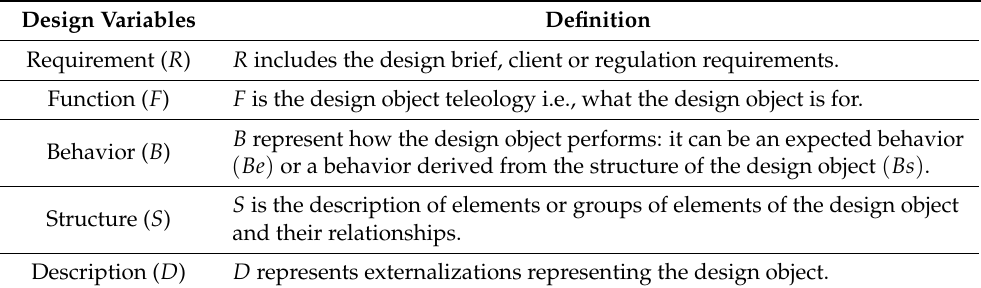
Table 1. The FBS model and definitions of design variables